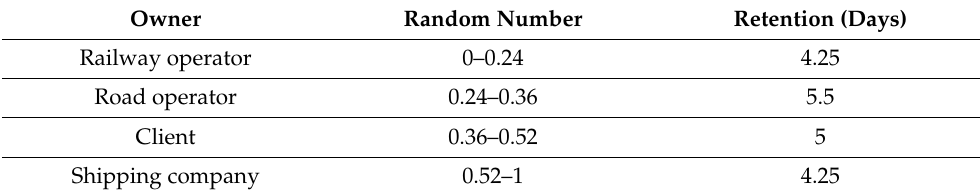
Table 13. Simulation of container retention according to container owner.